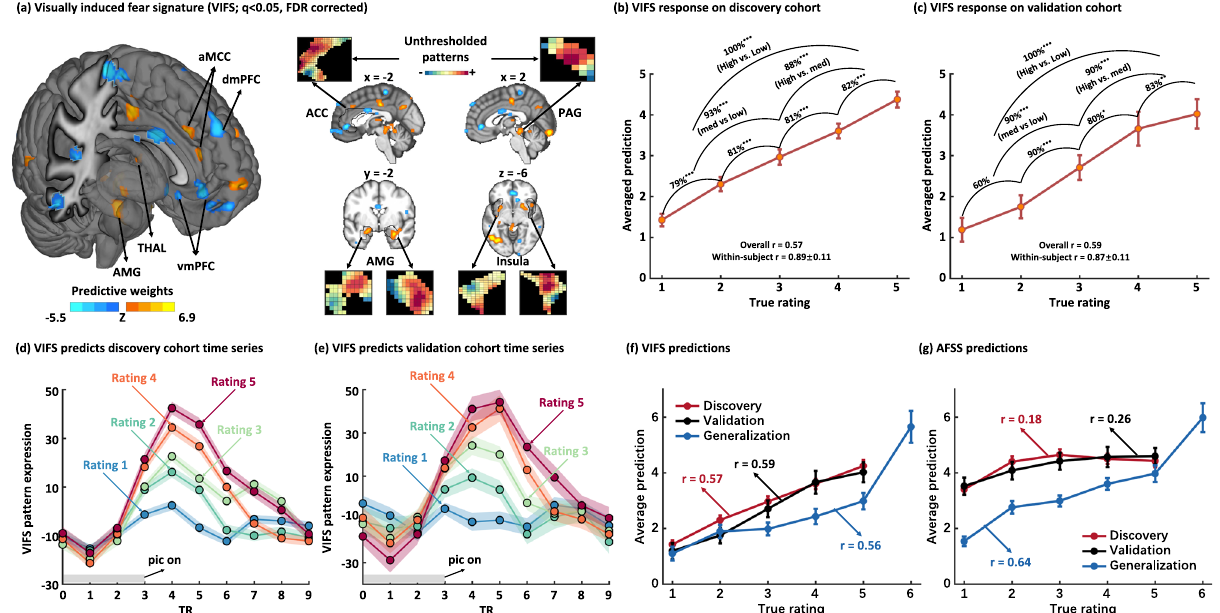
Fig. 2 Visually induced fear signature (VIFS). a depicts the VIFS pattern thresholded using a 10,000-sample bootstrap procedure at q < 0.05, FDR corrected. Inserts show the spatial topography of the unthresholded patterns in the left ACC, right PAG, bilateral AMG, and bilateral insula. AMG denotes amygdala, THAL thalamus, vmPFC ventromedial prefrontal cortex, dmPFC dorsal medial prefrontal cortex, dACC dorsal anterior cingulate cortex, MCC middle cingulate cortex, ACC anterior cingulate cortex, and PAG periaqueductal gray. b , c depict the predicted fear experience (subjective ratings; mean ± SE) compared to the actual level of fear for the cross-validated discovery cohort and the independent validation cohort, respectively. Accuracies re fl ect forced-choice comparisons. Two-sided binomial tests were used to test whether the classi fi cation accuracies were higher than chance level. r indicates the Pearson correlation coef fi cient between predicted and true ratings. d , e depict an average peristimulus plot (mean ± SE) of the VIFS response to the cross-validated discovery cohort and the independent validation cohort. This re fl ects the average VIFS response at every repetition time (TR; 2 s) in the time series separated by the fear ratings. Of note, the VIFS reacts with a latency of approximate 4 s after stimulus onset which corresponds to the timing of the hemodynamic response function (HRF) following stimulus onset. f , g compare the fear prediction (mean ± SE) of AFSS with the VIFS on discover, validation, and generalization cohorts, respectively. * indicates P < 0.05, ** P < 0.01 and *** P < 0.001 (uncorrected). Error bars and shaded regions indicate SEs. VIFS visually induced fear signature, AFSS animal fear schema signature, SE standard error of mean. Source data are provided as a Source Data fi